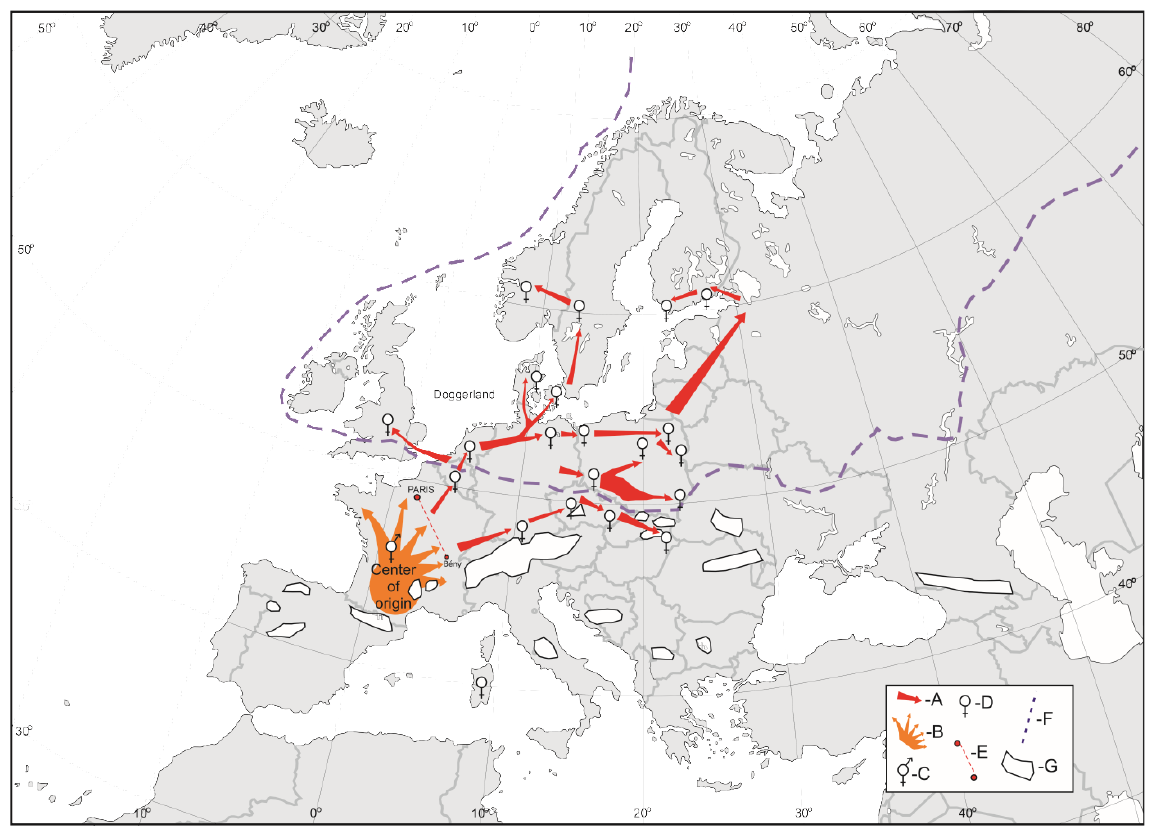
Figure 6. Hypothetical migration routes of Labidostomma luteum after glaciation: A — direction of dispersion of populations consisting only of females; B,C — populations consisting of males and females; D — populations consisting only of females; E — boundary of populations consisting of males and females; F — range of glaciation in Europe; G — local mountain glaciations.